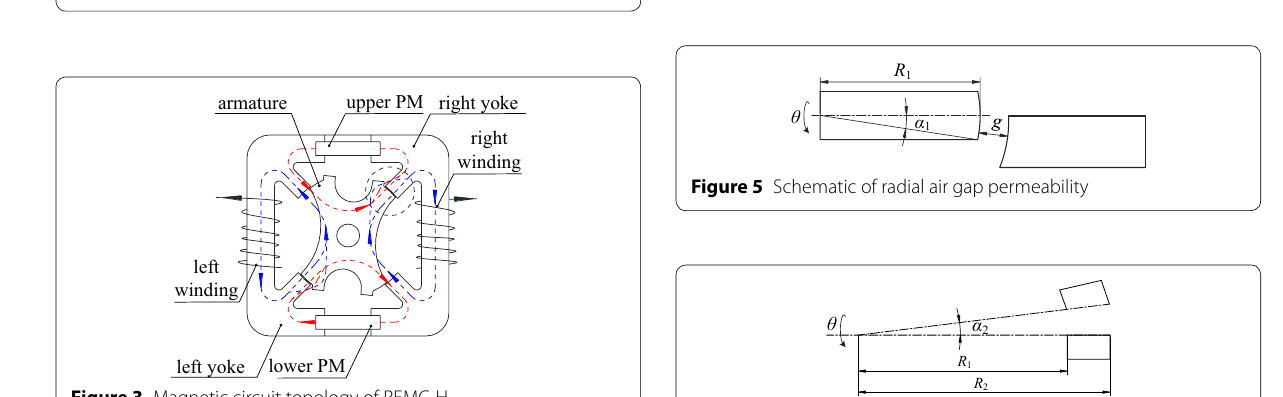
Figure 2 Structure schematic of REMC-H